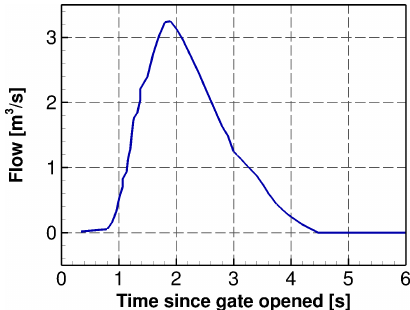
Figure B7. Unsteady inflow boundary condition corresponds to the cross-section flow measured at a location of 2m downstream of the gate (Iverson et al., 2010).